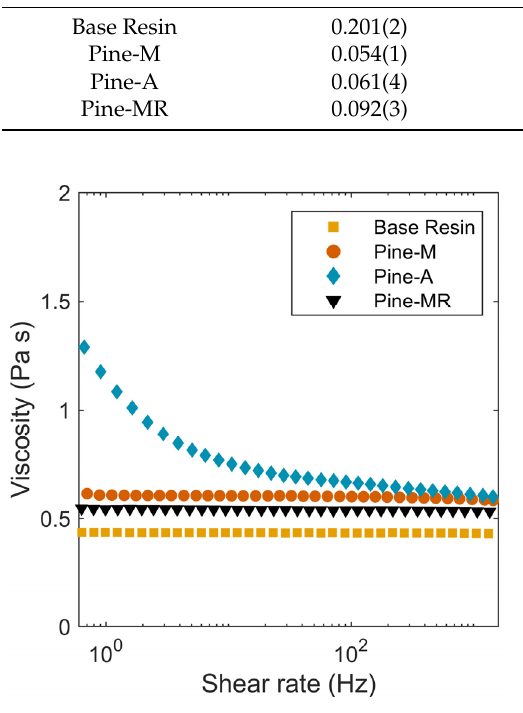
Figure 4. Viscosity versus shear rate for the base resin and lignin resins.